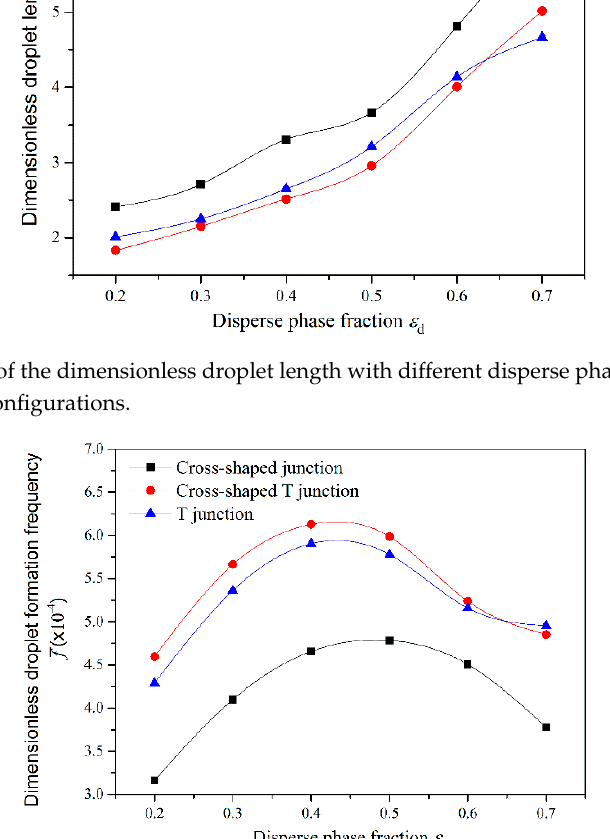
Figure 6. Variation of dimensionless droplet formation frequency with different disperse phase fractions